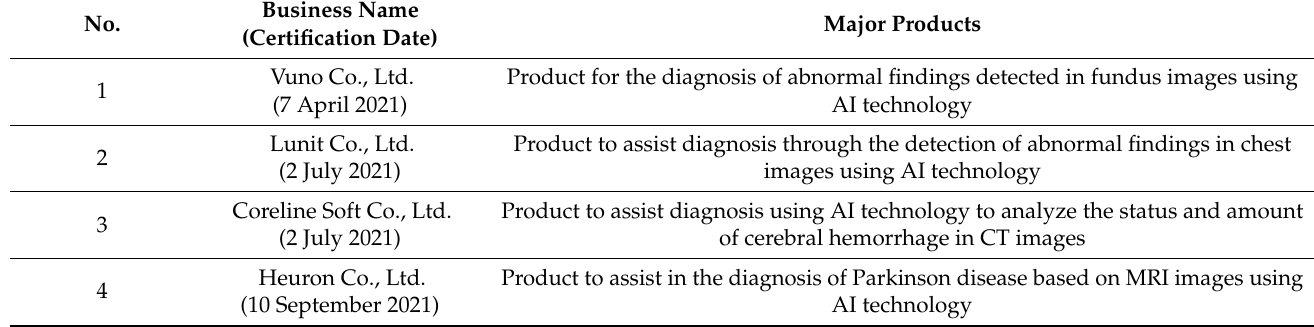
Table 2. Certification status for businesses manufacturing innovative medical device software in